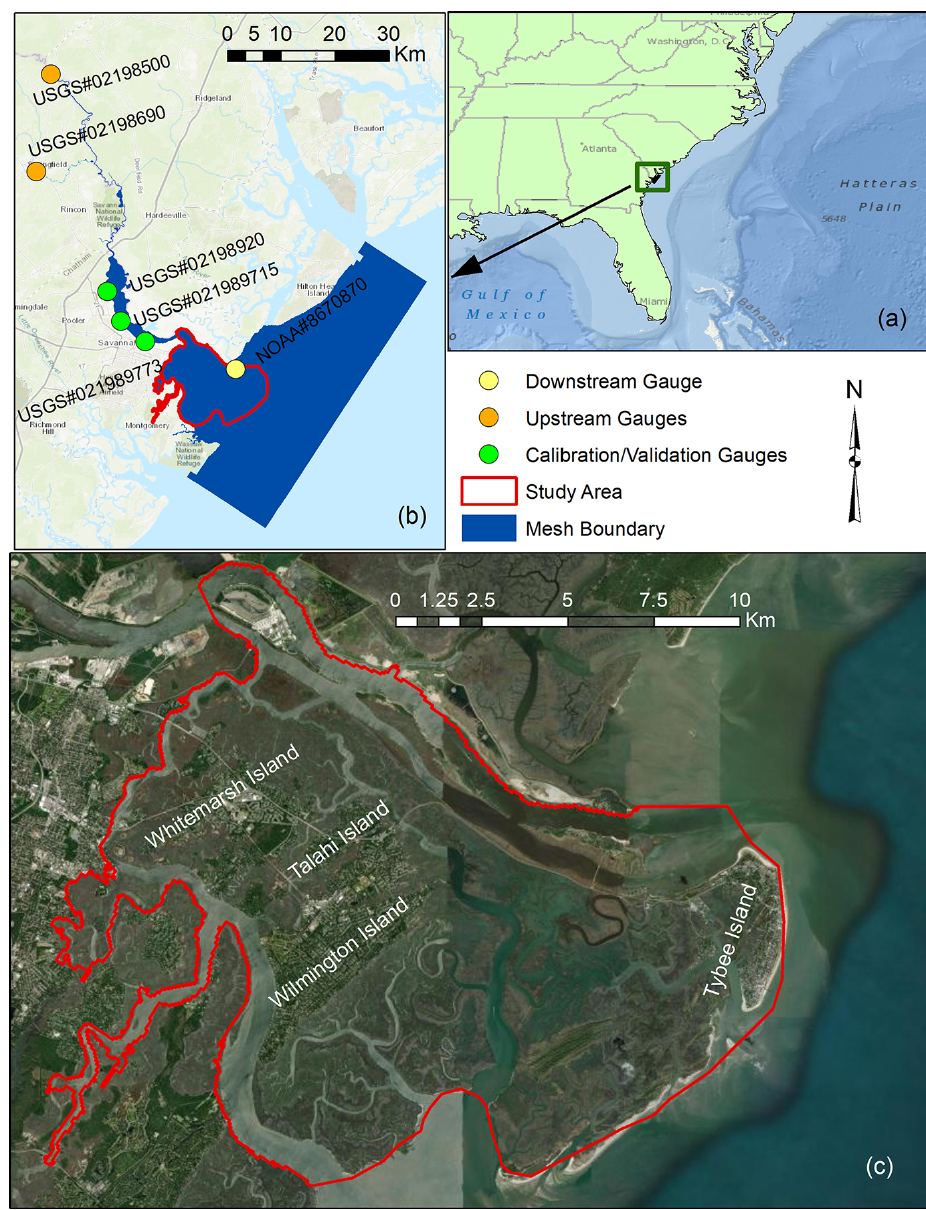
Figure 1. Map of the study area and mesh boundary of the hydrodynamic model. (a) The geographic location of the study area in the southeast USA. (b) The mesh boundary used by the hydrodynamic model (blue) for flood inundation mapping as well as the location of upstream (orange), downstream (yellow), and calibration/validation (green) gauges, and (c) the boundary of Savannah wetlands used as the case study along with urbanized areas (Esri